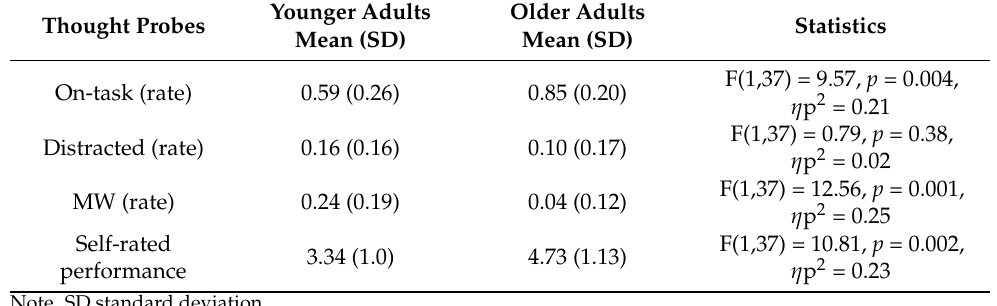
Table 3. The age effect on self-reported attentional control.